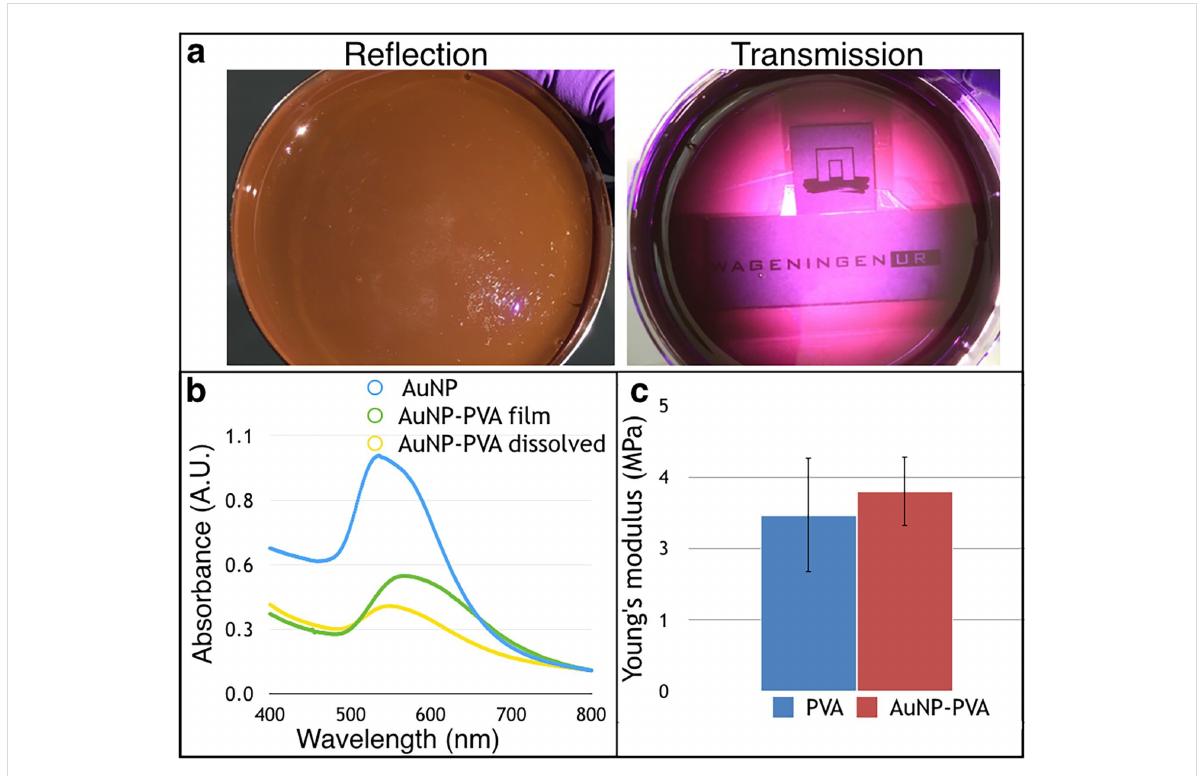
Figure 2: a) AuNP–PVA shows an opaque brown color in reflection and transparent purple in transmission. The transparency effect allows the text behind the plastic to be read. b) UV–vis spectra of the dichroic AuNPs (blue) and AuNP–PVA film (green) which shows a red shift probably due to